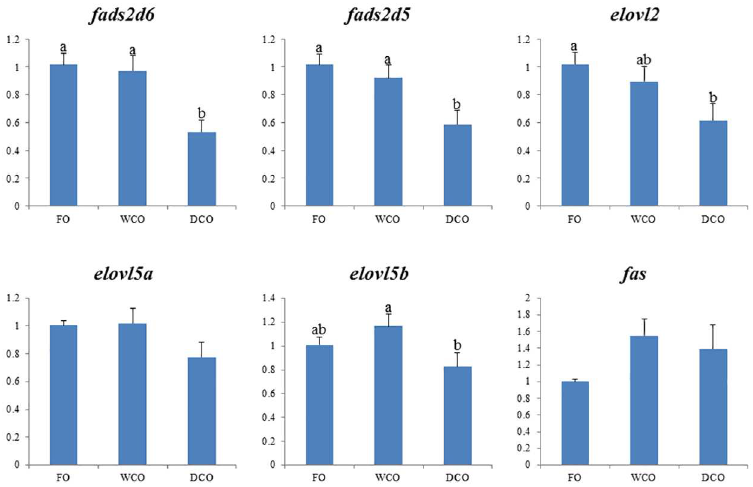
Fig 9. Expression of genes of the LC-PUFA biosynthesis pathway in midgut of Atlantic salmon as determined by qPCR. Results are normalizedexpression ratios (means ± SEM; n = 6). FO, fish oil diet; WCO, wild type camelinaoil diet; DCO, EPA+DHA camelinaoil diet. fads2d6 ,delta-6 fatty acyl desaturase; fads2d5 ,delta-5 fatty acyl desaturase; elovl2 , fatty acyl elongase2; elovl5a ,fatty acyl elongase 5 isoform a; elovl5b ,fatty acyl elongase 5 isoform b; fas , fatty acid synthase. Different superscript letters denote differences amongtreatments identifiedby one-wayANOVA.